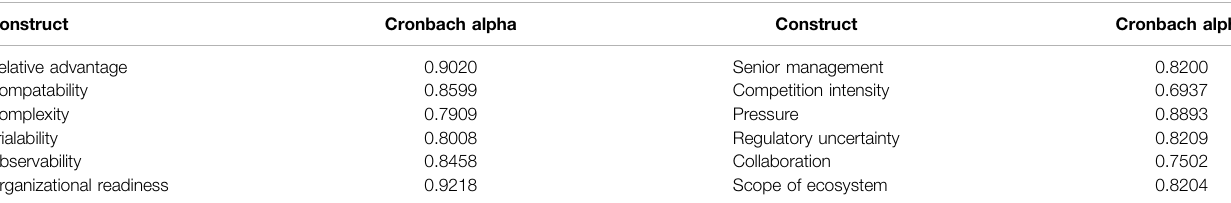
TABLE 4 | Cronbach Alpha for each Construct.